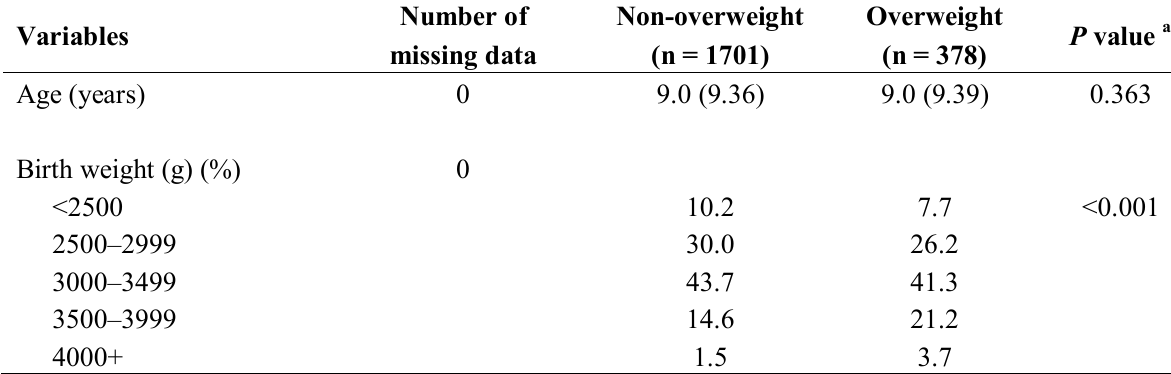
Table 1. Characteristics of non-overweight and overweight study participants